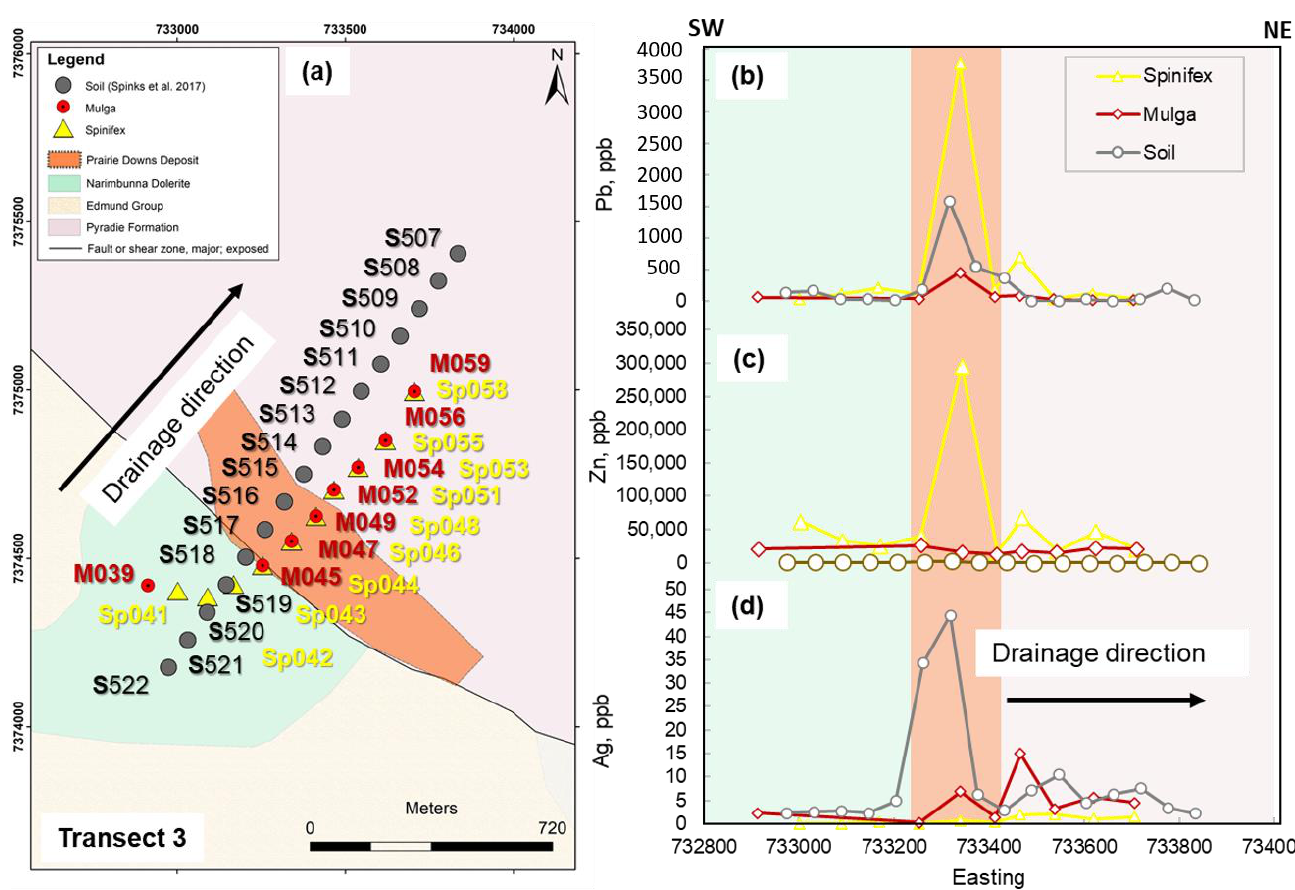
Figure 8. Metal concentrations in mulga, spinifex and soil samples along transect T3 (Prairie deposit). ( a ) Location of samples along transect T3 over the Prairie deposit. ( b ) Lead concentrations in mulga, spinifex and Fe–Mn crust samples along transect T3. ( c ) Zinc concentrations in mulga, spinifex and Fe–Mn crust samples along transect T3. ( d ) Silver concentrations in mulga, spinifex and Fe–Mn crust samples along transect T3.